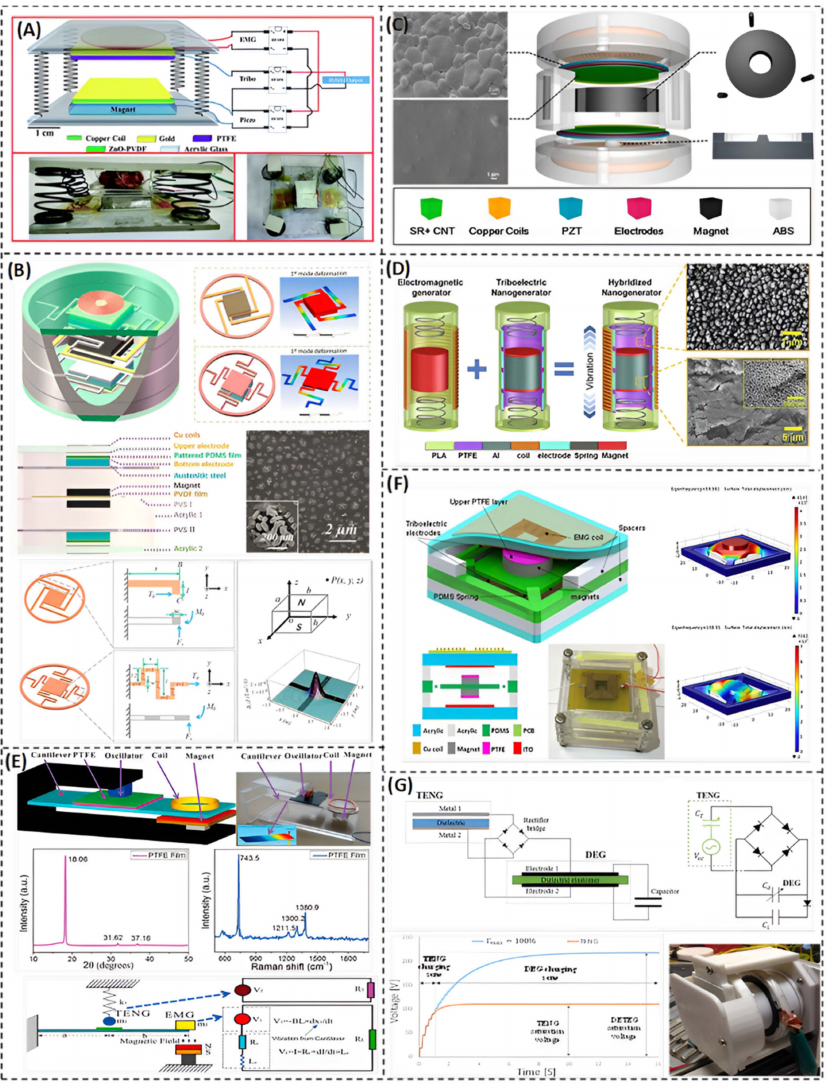
Figure 4. Hybrid TENG-based vibration energy harvesting. ( A ) Vibration energy harvester based on combining different devices in order to increase the efficiency and applicability (Reprinted with permission [70], copyright 2021, Royal Society of Chemistry). ( B ) A piezoelectric–electromagnetic– triboelectric hybrid energy harvester that can scavenge vibrations with frequency ranged from 3.5